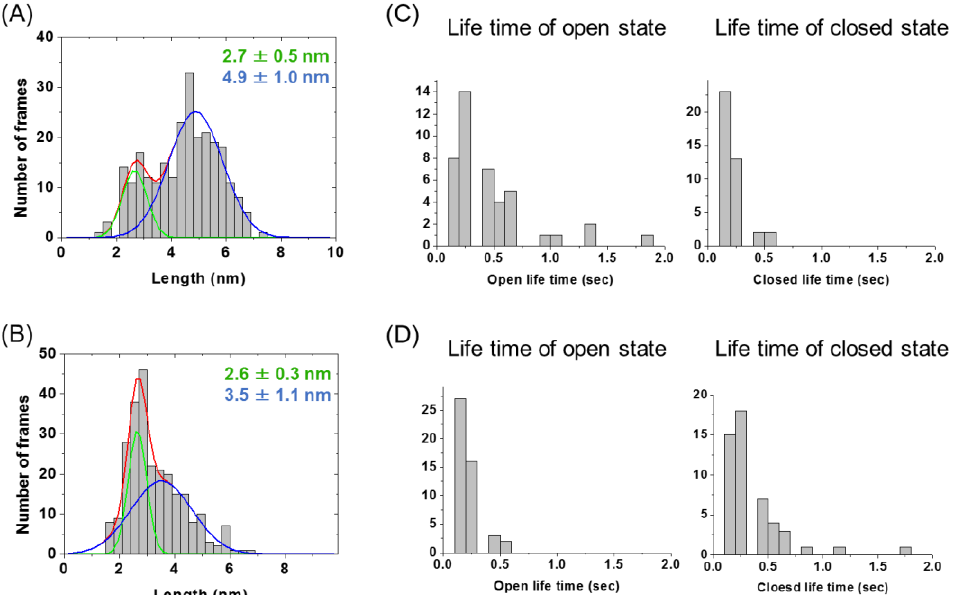
Figure 3. Histograms of the distance distribution between the VH and VL domains constructed from high-speed atomic force microscopy (HS-AFM) images for linear scFv ( A ) and cyclic scFv ( B ). The fitted distribution lines for all scFv molecules are shown in red, molecules with shorter distances in green, and molecules with longer distances in blue. Life time of open state (distance of over 3.5 nm between the VH and VL domain) and closed state (under 3.5 nm) for linear scFv ( C ) and cyclic scFv ( D ).